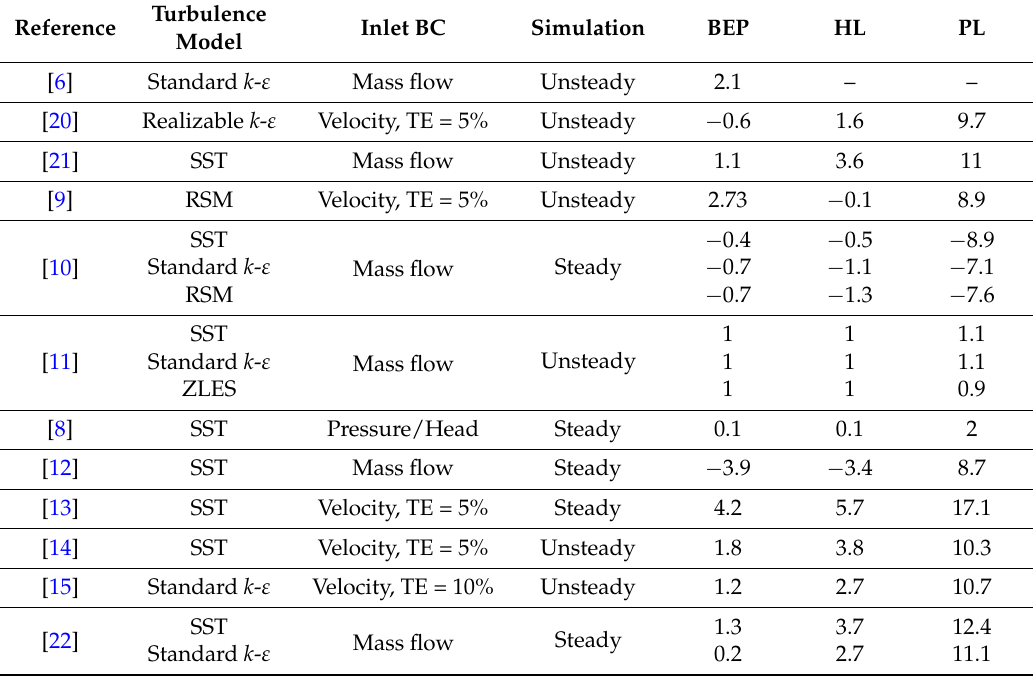
Table 4. Difference in hydraulic efficiency ( η ) of the numerical model at BEP, HL, and PL